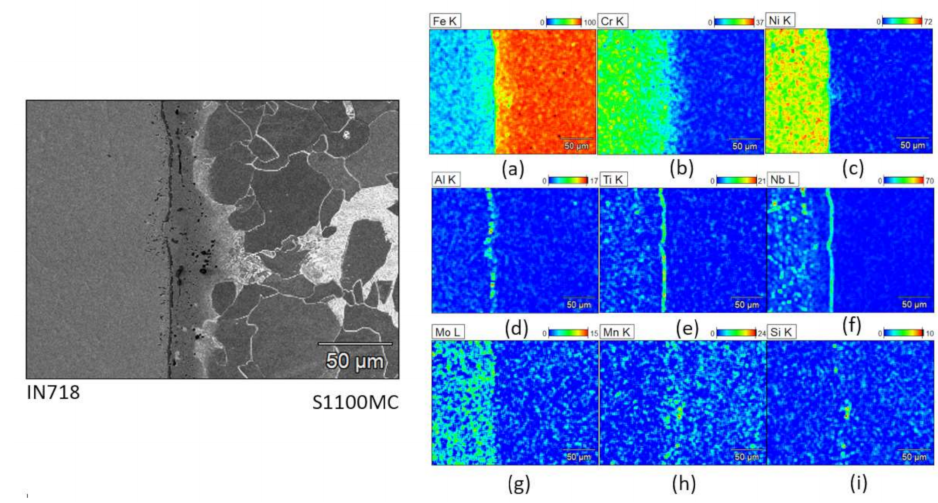
Figure 9. Micrographs of the structure and composition in weight % of the S1100MC-IN718 joint area: ( a ) iron ( b ) chromium ( c ) nickel ( d ) aluminium ( e ) titanium ( f ) niobium ( g ) molybdenum ( h ) manganese ( i ) silicon.